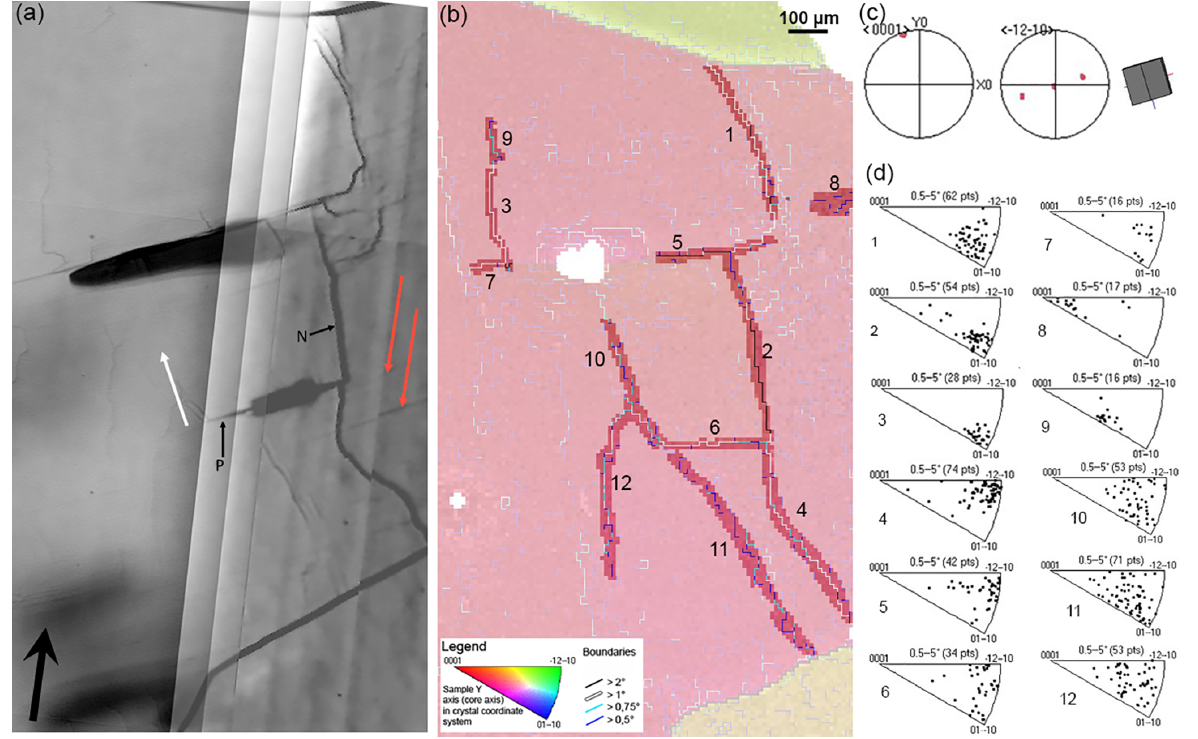
Figure 3. Microstructures used for the analysis of SGB types and slip systems: EDML sample (655.9m of depth). (a) LM image of a map of sublimation-etched surface. The black arrow points to the top of the ice core. The white arrow indicates the orientation of the c-axis. A P-type boundary and an N-type boundary are labelled as examples. The red arrows show SGBs in LM that are not observed in the corresponding EBSD map. (b) EBSD map of the same area showing subsets of SGBs labelled 1–12. (c) Pole figure of the central grain in the EBSD map showing the c- and a-axes and a schematic of the crystal orientation. (d) Rotation axes of neighbouring pixels across the SGBs